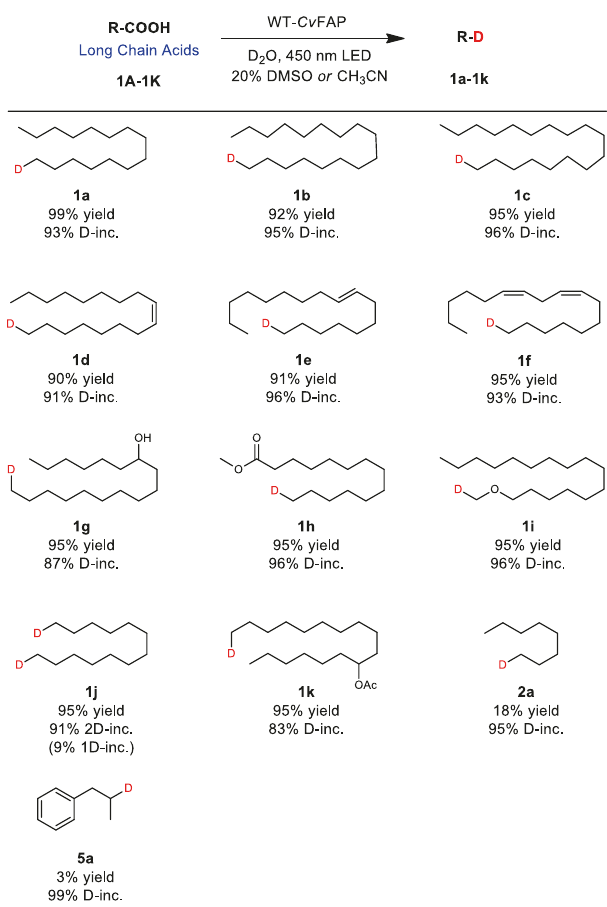
Fig. 2 Deuteration scope: long chain acids. Reaction conditions: